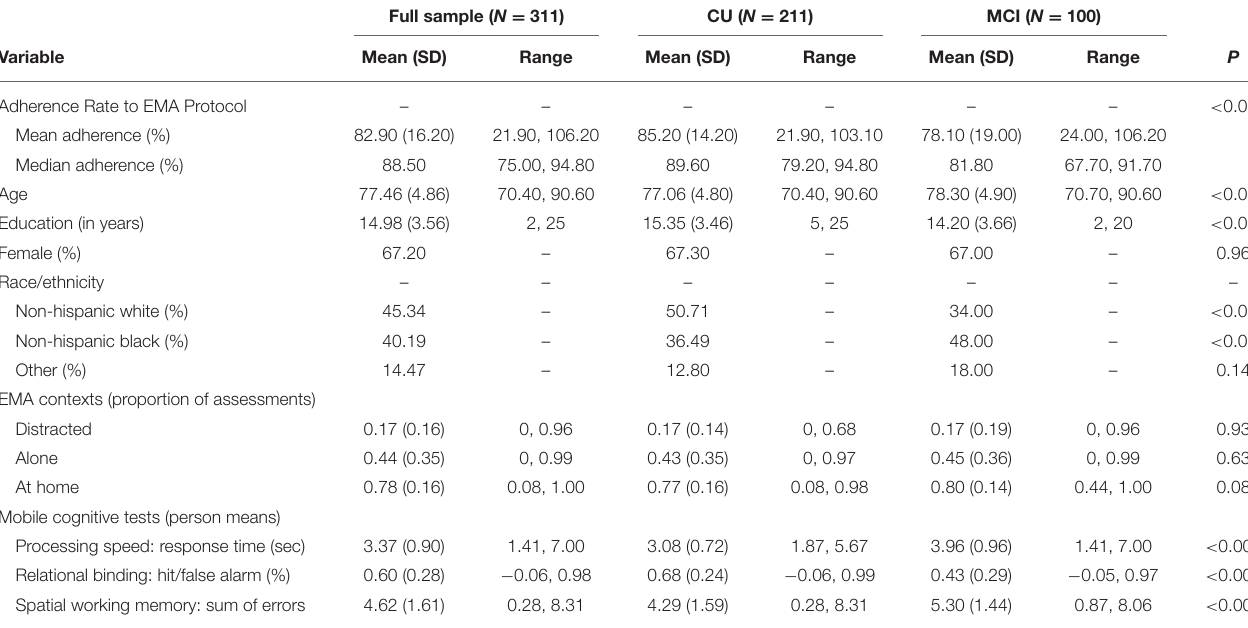
TABLE 1 | Descriptive statistics for sociodemographic variables, contextual variables, and mobile cognitive